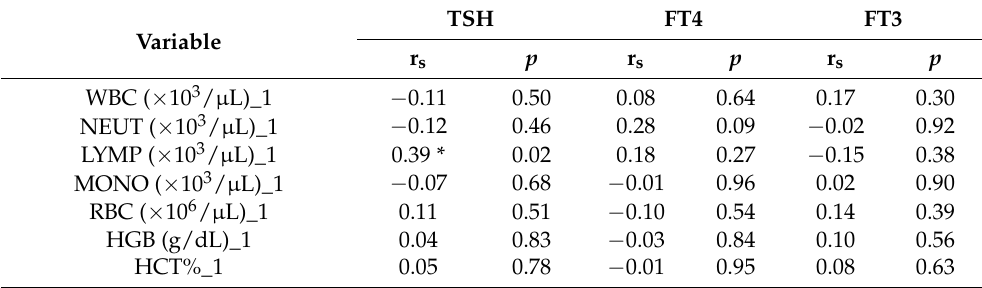
Table 3. Relationship of thyroid function assessment markers with routine parameters at 1